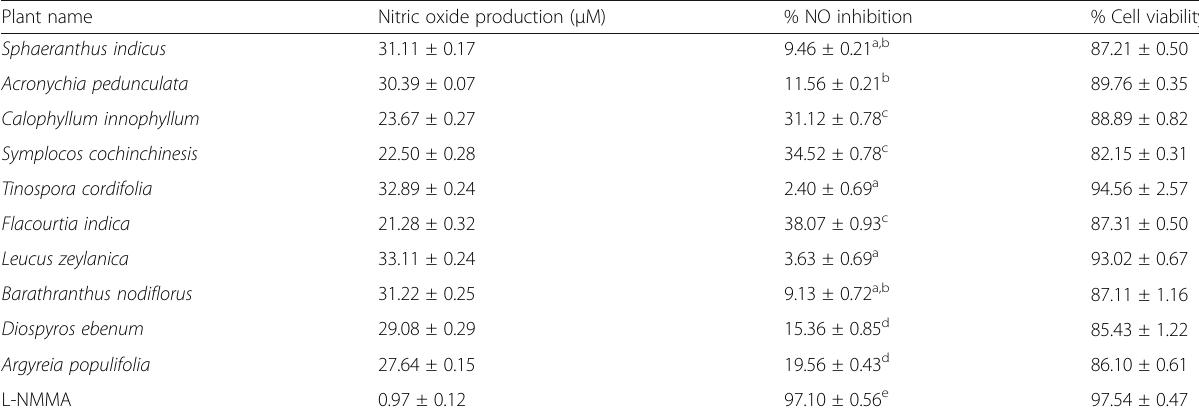
Table 4 Inhibitory activities of ethanol extracts of medicinal plants on nitric oxide production and viability of LPS-activated RAW264.7 macrophages